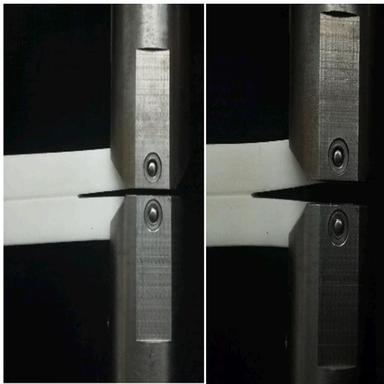
Experimental setup of DCB evidencing crack propagation.